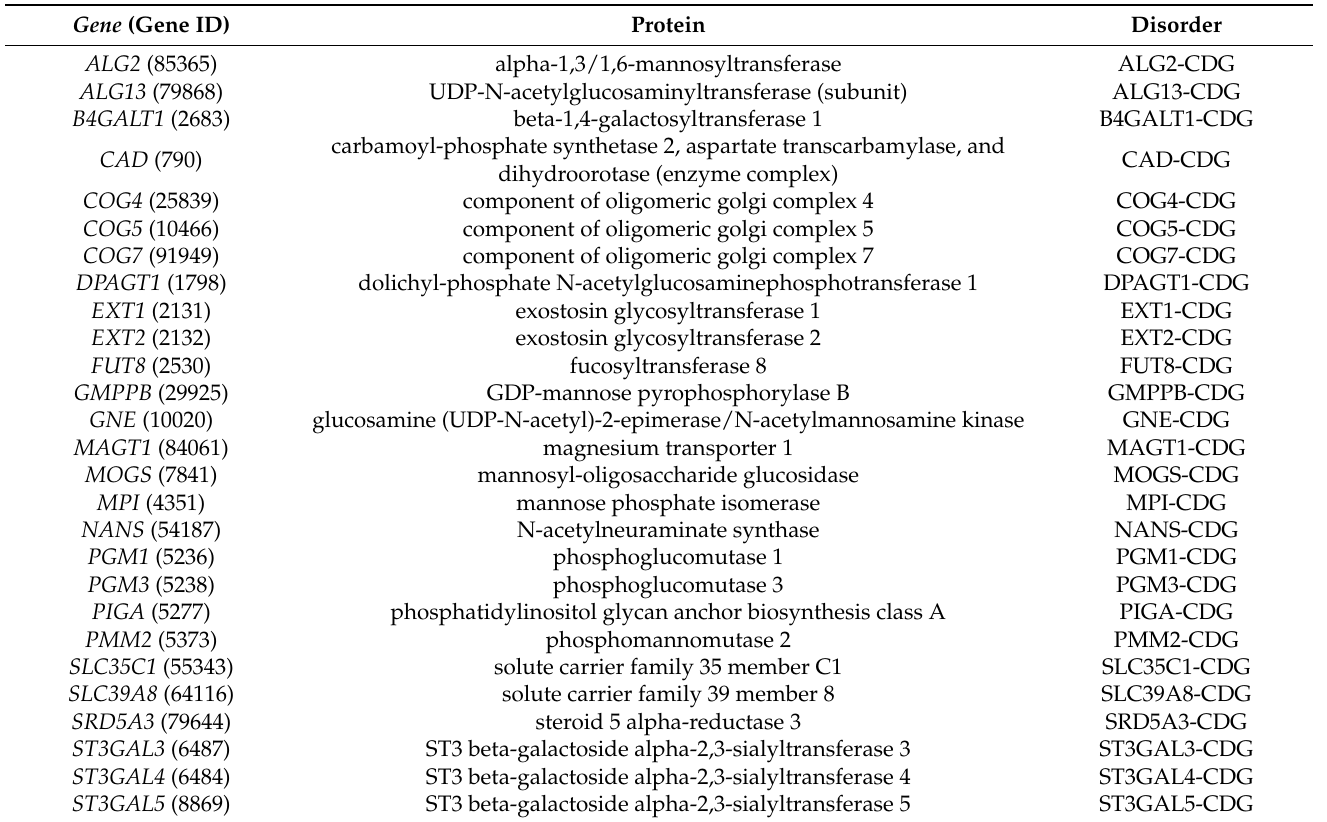
Table 1. Overview of mutated genes and respective proteins involved in some CDG. The gene identification number (ID) is taken from the Gene database of